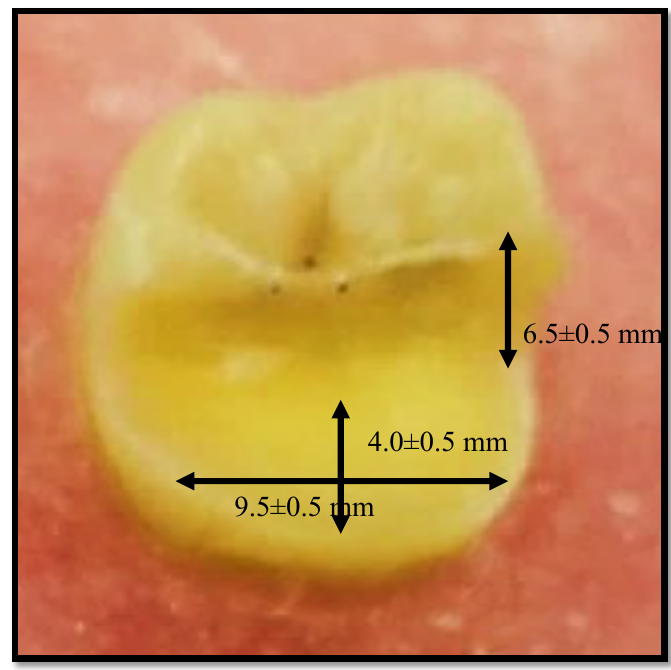
Figure 1. Cavity preparation